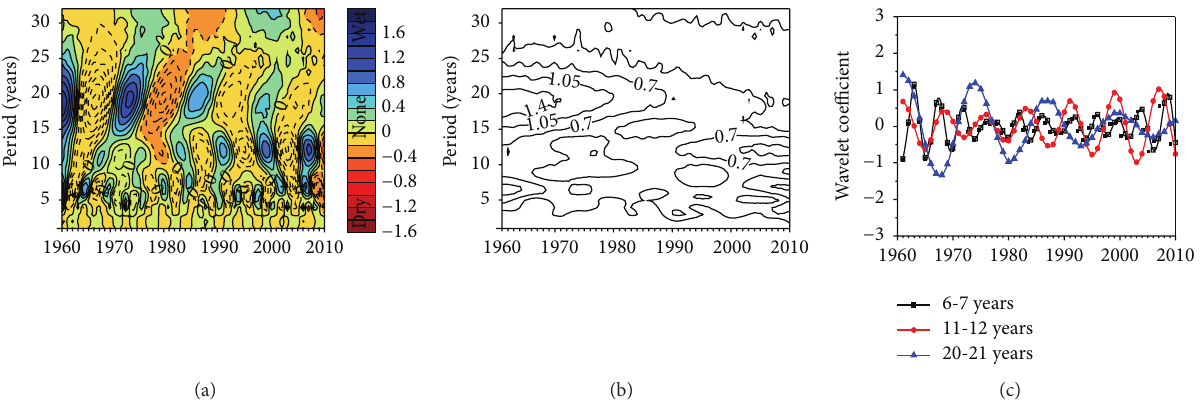
Figure 3: Annual SPI series of wavelet coefficients (a), annual SPI series of modulus square (b), and annual SPI series of wavelet coefficient of primary